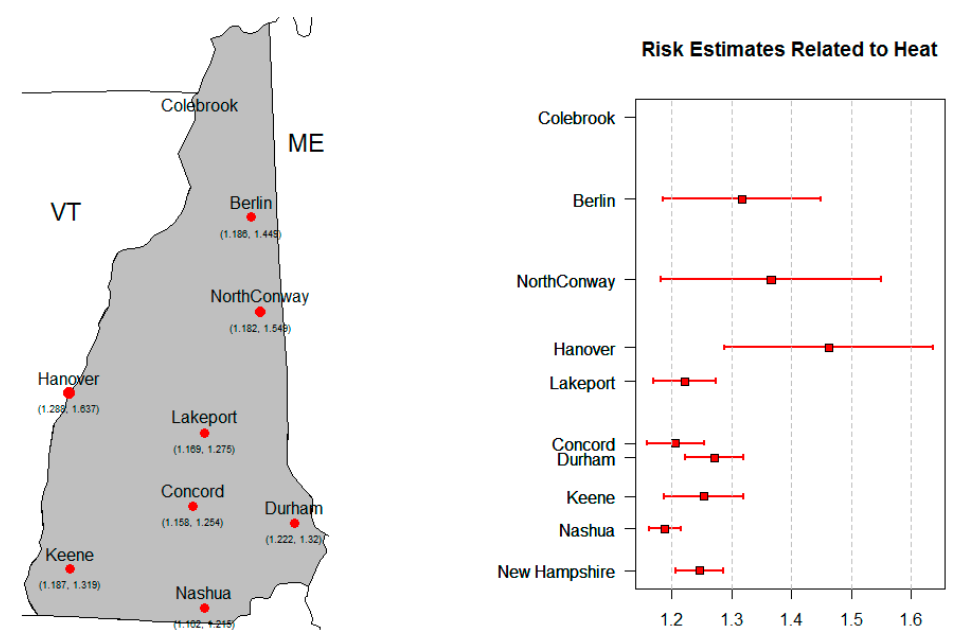
Figure 5. Risk estimates for hospital visits related to heat associated with a 1 ◦ C increase in temperature, reported with a 95% CI.